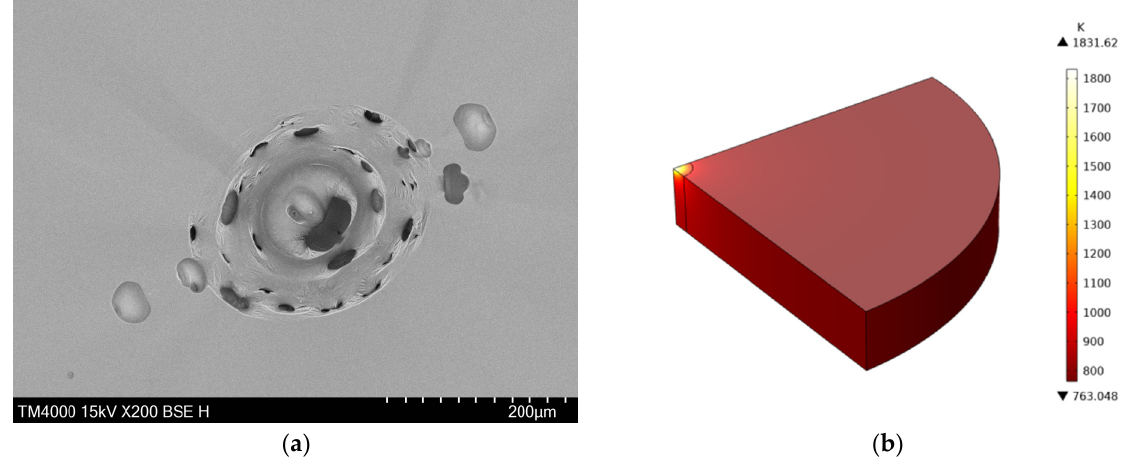
Figure 9. ( a ) is our use of EDS − SEM to observe the typical damage morphology of the single crystal silicon surface irradiated by continuous wave laser, and ( b ) is the simulation of the experimental process.